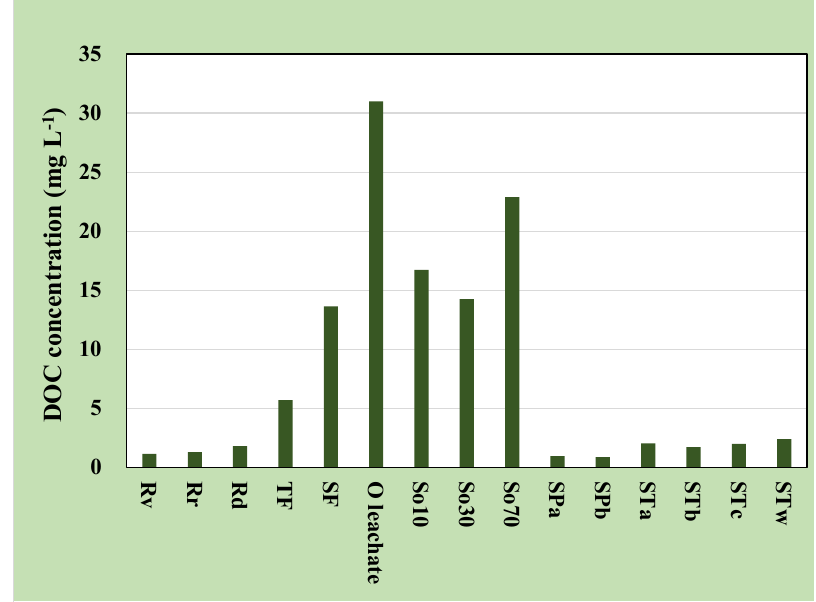
Figure 4. Average of DOC concentration among all sample types at the YMS from July 2002 to March 2004. The number of measured samples is the same as that shown in Table S3. See Figure 1 for the meaning of the abbreviations.